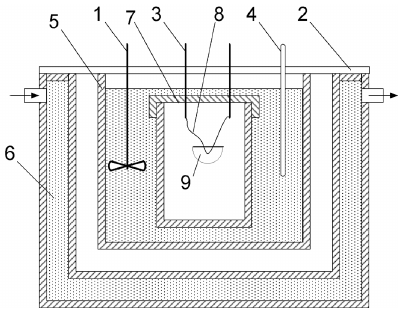
Fig. 8. Calorimeter parts: 1 – mixer for uniform mixing of wa-